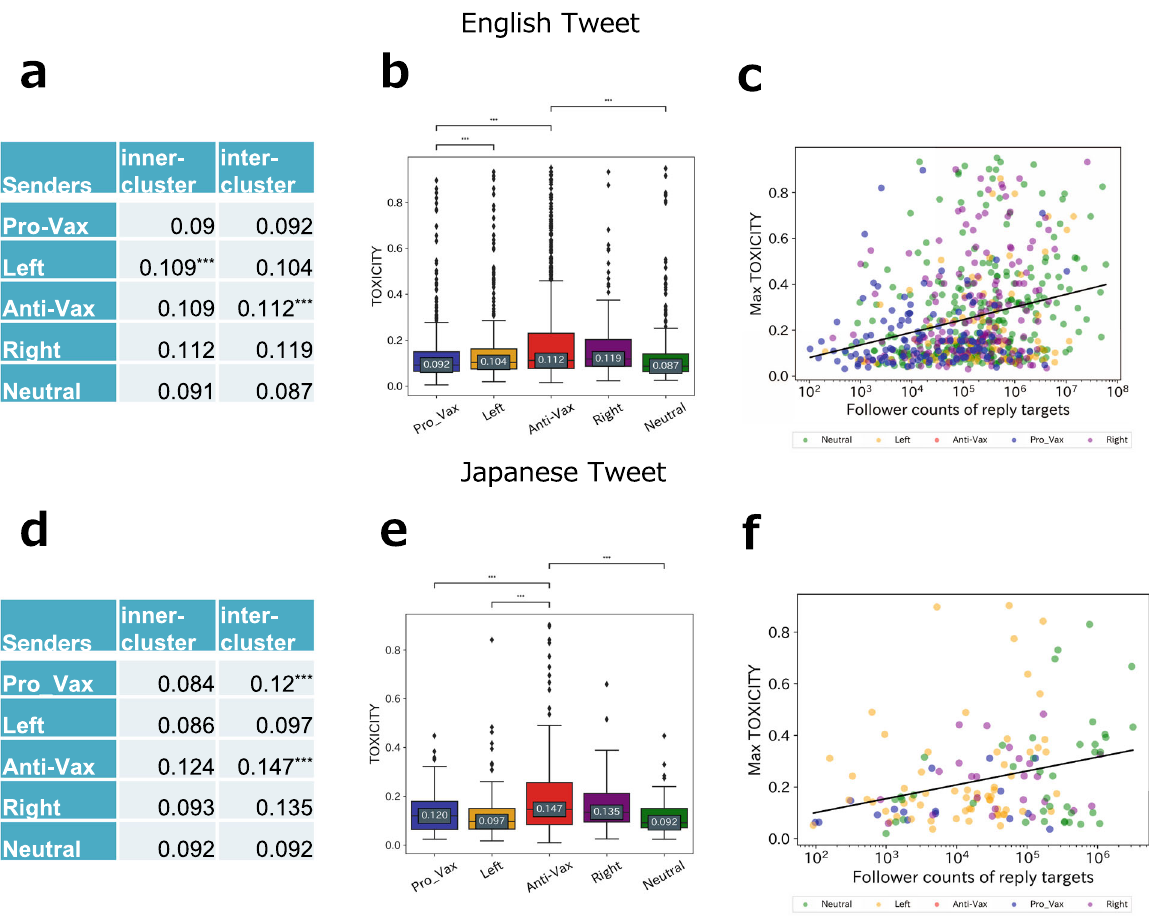
Fig. 4 Toxicity scores. a Median toxicity scores of inner-cluster and inter-cluster replies from each cluster. The Anti-Vax's inter-cluster replies have a signi fi cantly higher toxicity score than its inner-cluster replies. The Left's inner-cluster replies have a signi fi cantly higher toxicity score than its inter-cluster replies. Both have p < 0.001 by Mann – Whitney U -test with Bonferroni correction. b Boxplots represent the toxicity of the inter-cluster replies from each cluster. Each data point indicates the toxicity of a reply. Each median score is annotated in the boxes. Replies from the Anti-Vax cluster were signi fi cantly more toxic than ones from the Pro-Vax and Neutral clusters in both languages ( *** p < 0.001 by Mann – Whitney U -test with a Bonferroni correction). c The maximum toxicities that one received from Anti-Vax users. Each data point in the fi gure is the users who received the reply. The x -axis is the number of followers of the users, and the y -axis is the toxicity of the replies received. The correlation coef fi cients are d : 0.02 ( p = 0.601), e : 0.198 ( p < 0.001), h : 0.096 ( p = 0.254), and 0.268 ( p < 0.005). d , e , and f are Japanese counterparts of a , b , and c , respectively.